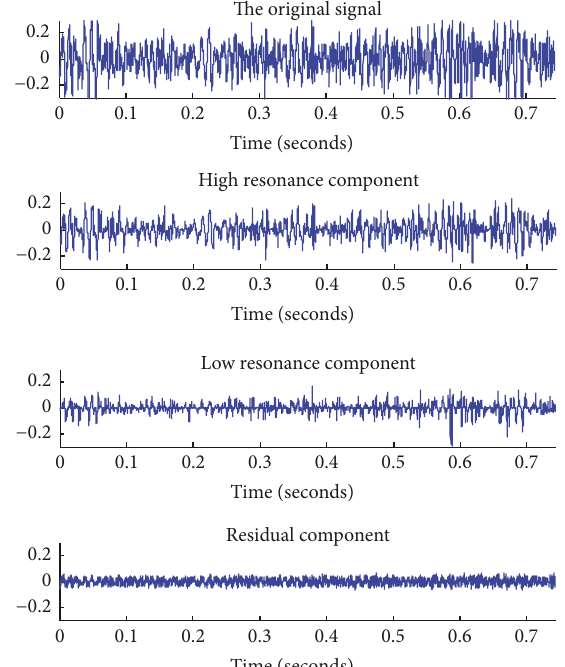
Figure 5: Decomposition of one ship radiated signal of noise A with white Gaussian noise into high resonance, low resonance, and residual component by using RSSD.